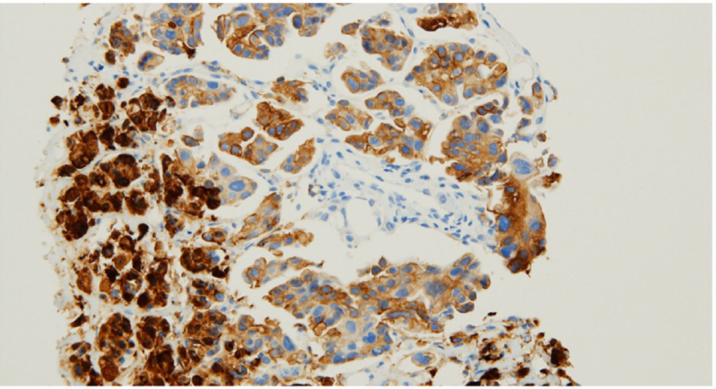
Figure 2. Percutaneous needle biopsy was conducted in the right diaphragm, and the specimen was submitted for histopathological examinations (Figure 2). To exclude the possibility of metastatic papillary carcinoma from the lung or thyroid origins and papillary mesothelioma, the immunohis- tochemical stains for TTF-1, napsin-A, thyroglobulin, calretinin, and D2-40 were performed, but none were reactive to the tumor cells. Finally, tumor cells were positive with the paired-box gene 8 (PAX8), which led to the diagnosis of ovarian serous papillary carcinoma (A) [2]. Ovarian cancers are usually confined to the abdominopelvic cavity because they spread mainly via the direct extension or peritoneal surface implantation followed by intraperitoneal lymphatic spread [3,4]. Metastases to intrathoracic lymph nodes are infrequent, reporting a low rate of 2.3% (six out of 255 cases) [5]. Metastases of ovarian carcinoma to intrathoracic lymph nodes tend to follow a predictable pattern: the afferent lymphatics drain from the diaphragm, liver, pleura, and anterior abdominal wall and empty into the internal mammary chain [6]. The natural spreading pattern of ovarian cancer includes extensive tumor dissemination on the peritoneal and pleural spaces first before intrathoracic lymph node metastases [7]. Therefore, the manifestation of isolated distant lymph node metastasis without any indication of primary malignant lesions or seeding metastases in the pelvic cavity is very rare during the initial staging setting [8]. Possible pathways for tumor spread in our case are still ques- tionable, considering that the serosal surfaces and intraabdominal viscera were unaffected. Isolated intrathoracic lymph node metastases is known to be an important predictor of overall survival, resulting in advanced stages and poor prognosis [7,9]. 18 F-FDG PET/CT may identify the initial manifestation of unexpected distant oligometastatic statuses of an unknown primary ovarian